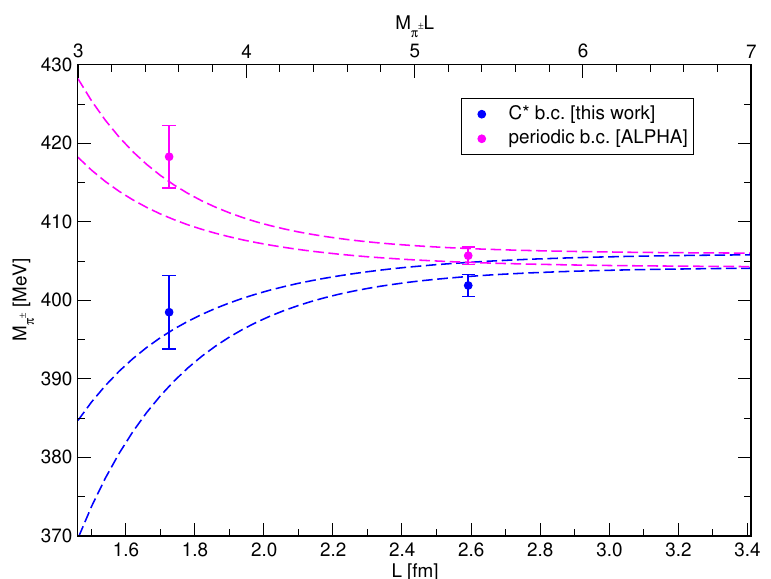
Figure 3 . Pion masses for our A400a00b324 and B400a00b324 ensembles with C ? boundary conditions, and for the A1 and A2 from [57] with periodic boundary conditions. In both cases physical units have been introduced by setting (8 t 0 ) 1 / 2 = 0 . 415 fm [51]. The curves are the results of the simultaneous fit to the LO χ PT formulae with uncertainty bands.